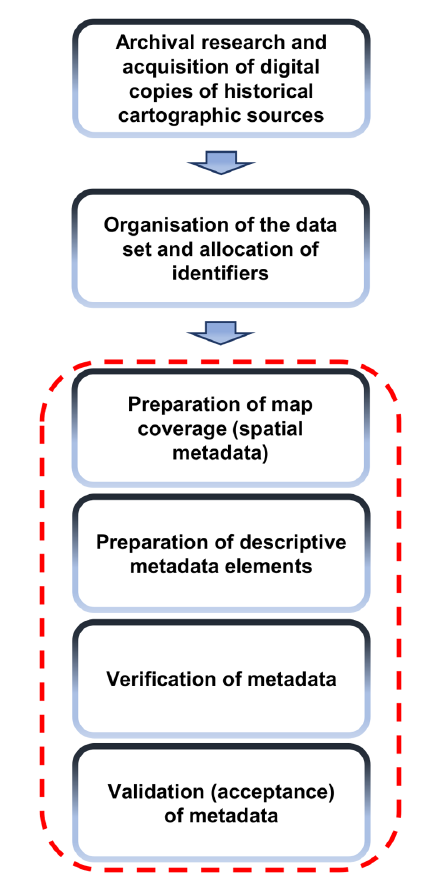
Fig. 4. Procedure for creation of metadata in the project (author’s